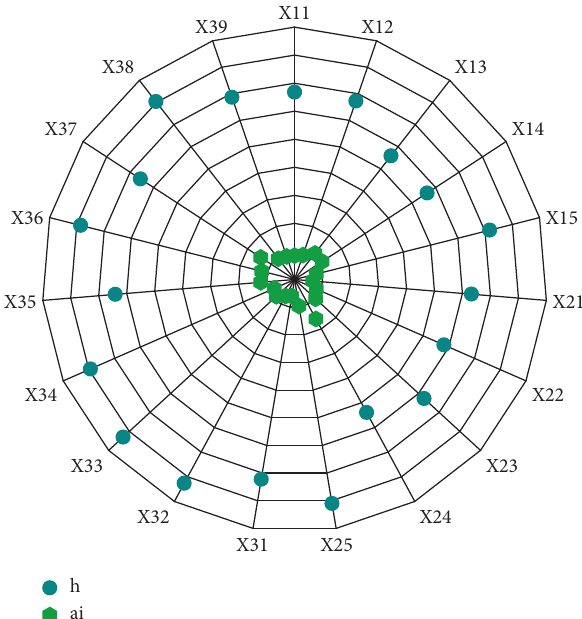
Figure 7: Entropy value and coefficient of variation of each